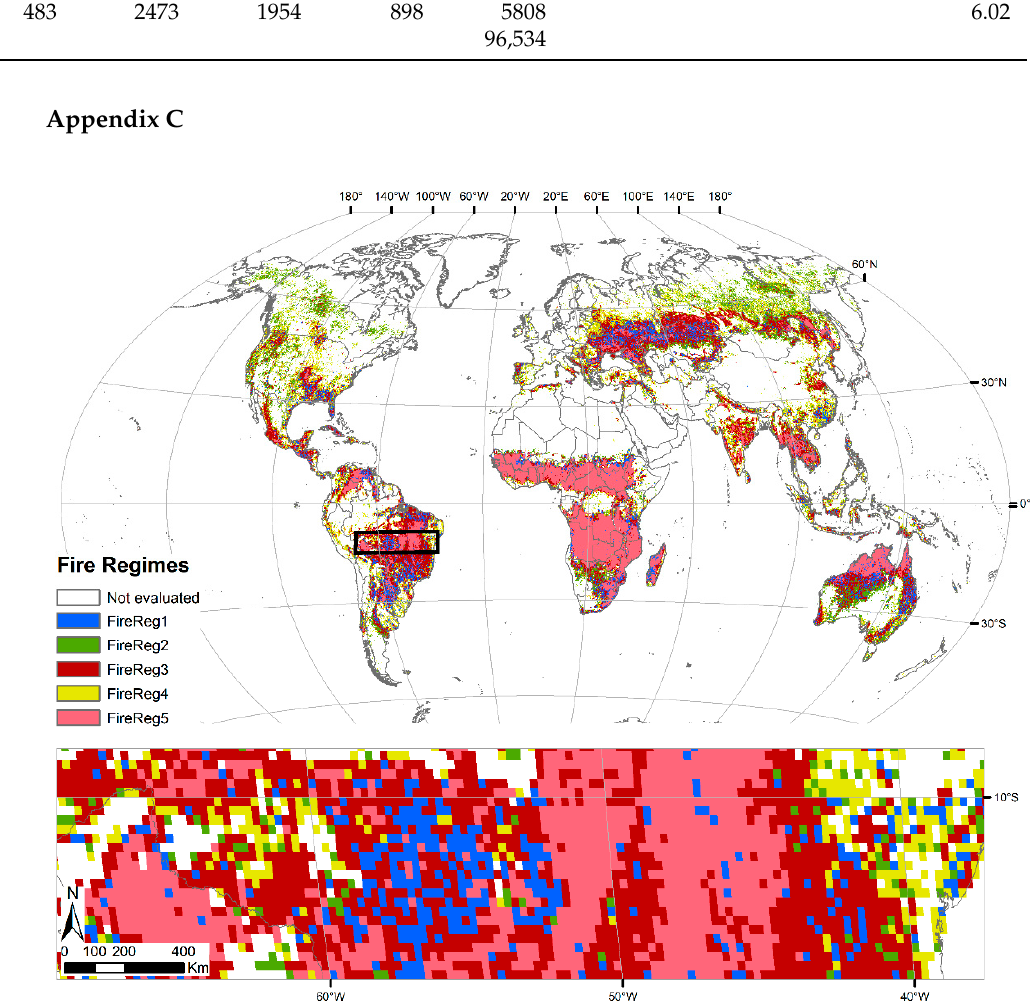
Figure A7. Spatial distribution of the global fire regimes identified from the remotely sensed products selecting five clusters as the optimal number of groups. The bottom panel shows a zoomed region in central South America, as delineated in the global map.